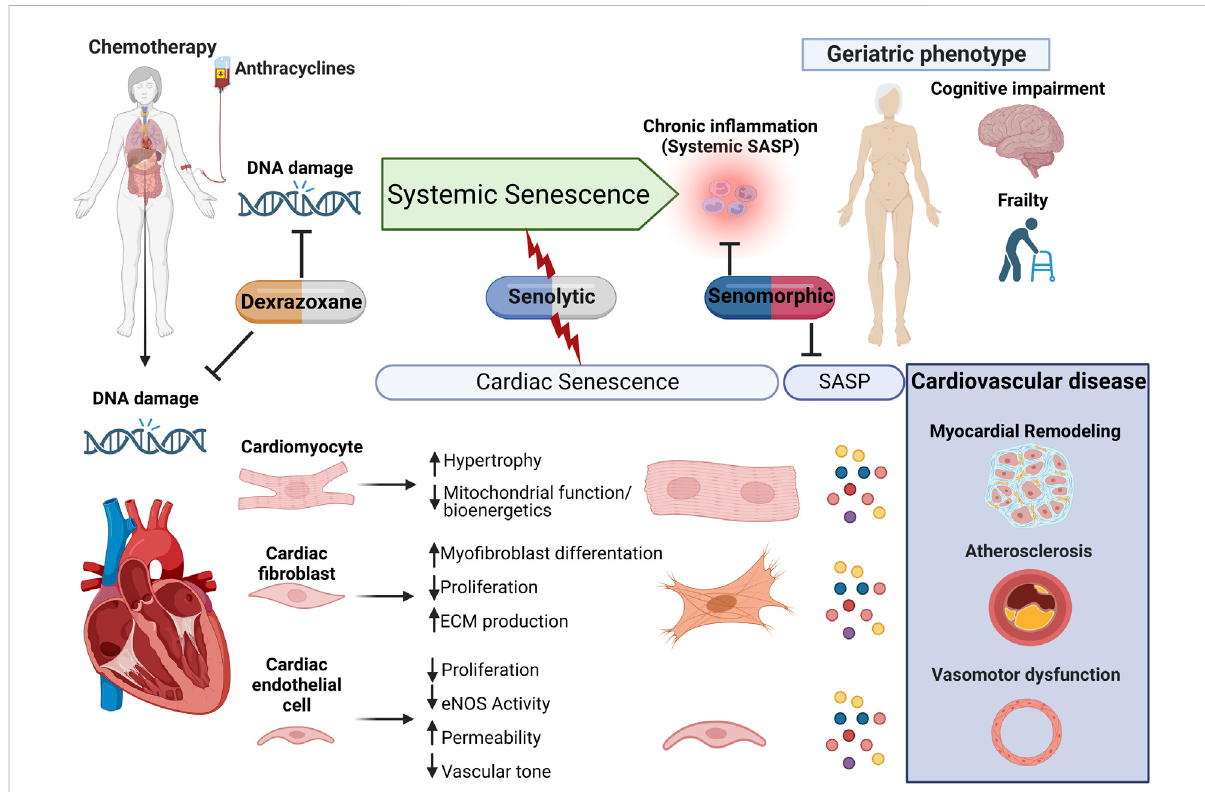
Proposed model for anthracycline-induced senescence in cardiotoxicity. We propose a model in which anthracyclines, through several interdependent mechanisms culminating in persistent DNA damage, induce systemic senescence and drive a geriatric phenotype. In the heart, senescence is induced in several cell populations which collectively contribute to age-related cardiovascular diseases, including myocardial remodeling, both directly and via expression of the senescence-associated secretory phenotype (SASP). This raises therapeutic opportunities through either elimination of senescent cells or modulation of the senescent phenotype for the management of anthracycline-induced cardiotoxicity and potentially less well-studied systemic